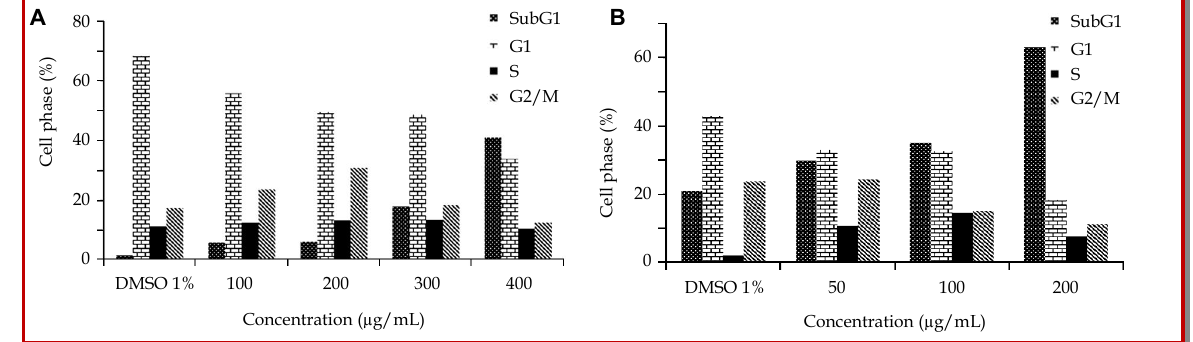
Figure 4: Effect of Acroptilon repens extract on cell cycle distribution of MCF-7 cells (A) and MDA-MB-468 cells